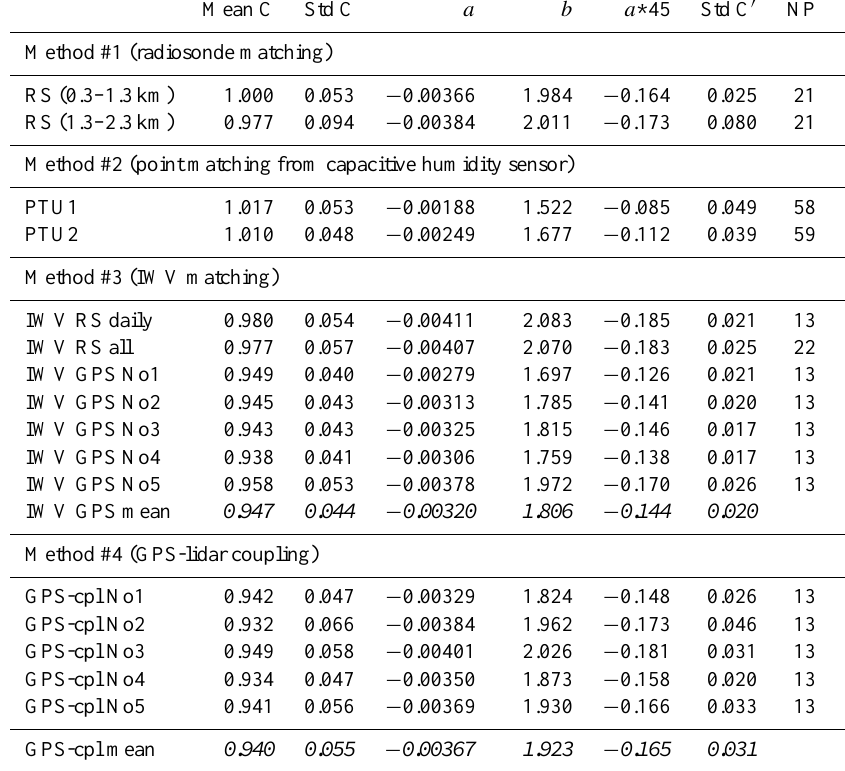
Table 2. Comparison of calibration factors determined with the four methods described in Sect. 3.1. Mean C and Std C refer to the mean and standard deviation of the calibration factors; a and b are the linear fit parameters of the calibration factors as a function of day of year ( y = ax + b ), a *45 represents the drift in calibration factor over the 45 days of the experiment. Std C 0 is the standard deviation when the linear fit is removed; NP is the number of points. The numbers in italics are the mean values of the GPS results. Mean C Std